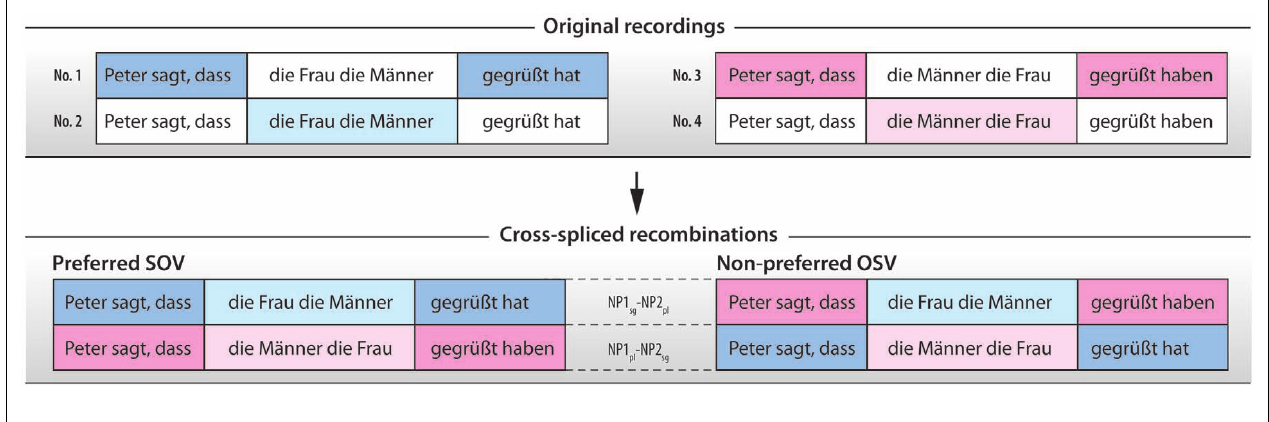
FIGURE 2 | Outline of the cross-splicing procedure for Experiment 1. Literal translation of the sentence on the left (portions used for cross-splicing are highlighted in blue): Peter says, that the woman the